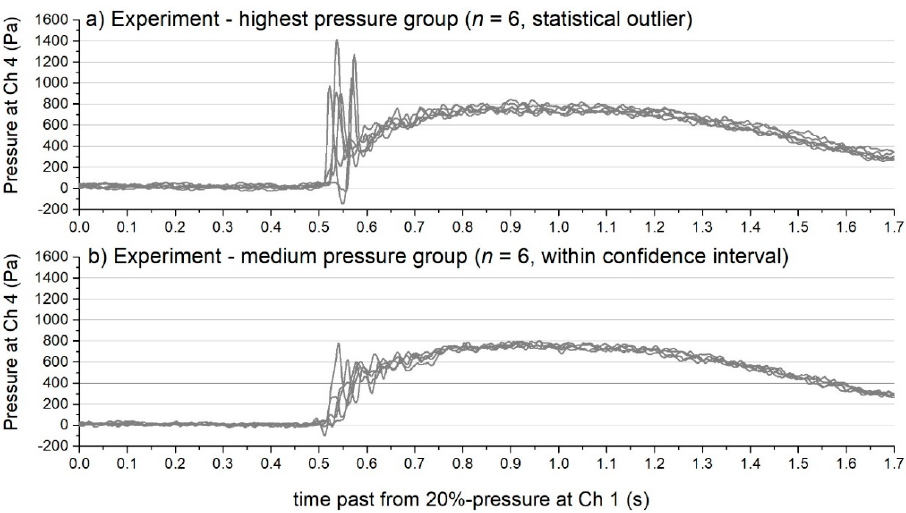
Figure 8. Time-series of pressure rise at Ch4 (gate speed = 1.11–1.56 m/s). ( a ) Experimental data for six statistically evaluated outliers; ( b ) Experimental data for six samples evaluated as normal and positioned within the interquartile range (IQR). Note that the time is started from the moment when each wave showed 20% of the maximum pressure at Ch1 to compare all profiles on the same time scale.